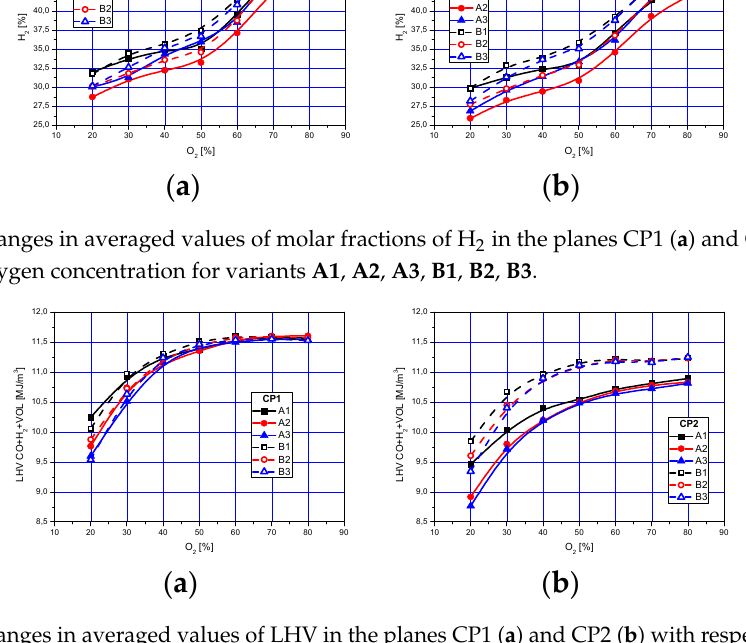
Figure 9. Changes in averaged values of LHV in the planes CP1 ( a ) and CP2 ( b ) with respect to oxygen concentration for variants A1 , A2 , A3 , B1 , B2 , B3 . Table 1. Proximate and ultimate analysis results of the fuel used for the current simulations (the values refer to a ‘dry’ state).